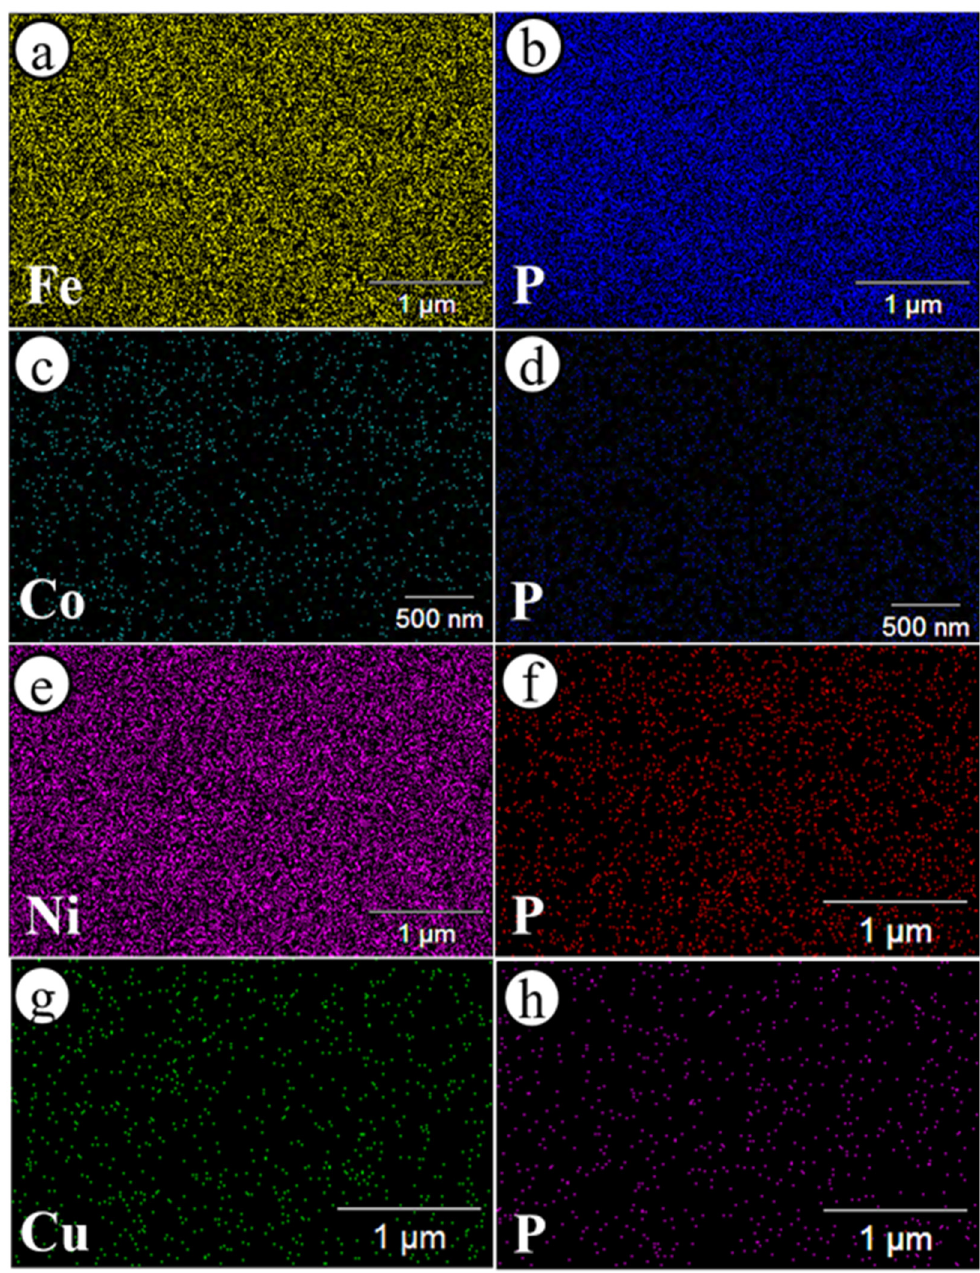
Figure 3. Elemental mapping of the PS ‐ 3D ‐ FeP@NiO|Ni ( a , b ), CoP@NiO ǀ Ni ( c , d ), NiP@ ‐ NiO ǀ Ni ( e , f ), and CuP@NiO ǀ Ni ( g , h ) electrodes.